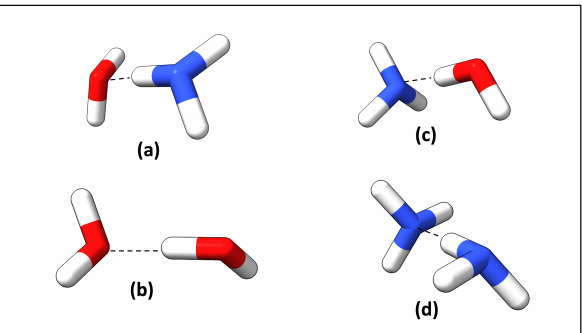
Figure 8. Four HB models prepared for comparison of GFN2-xTB with B3LYP-D3(BJ)/aug-cc-pVDZ.